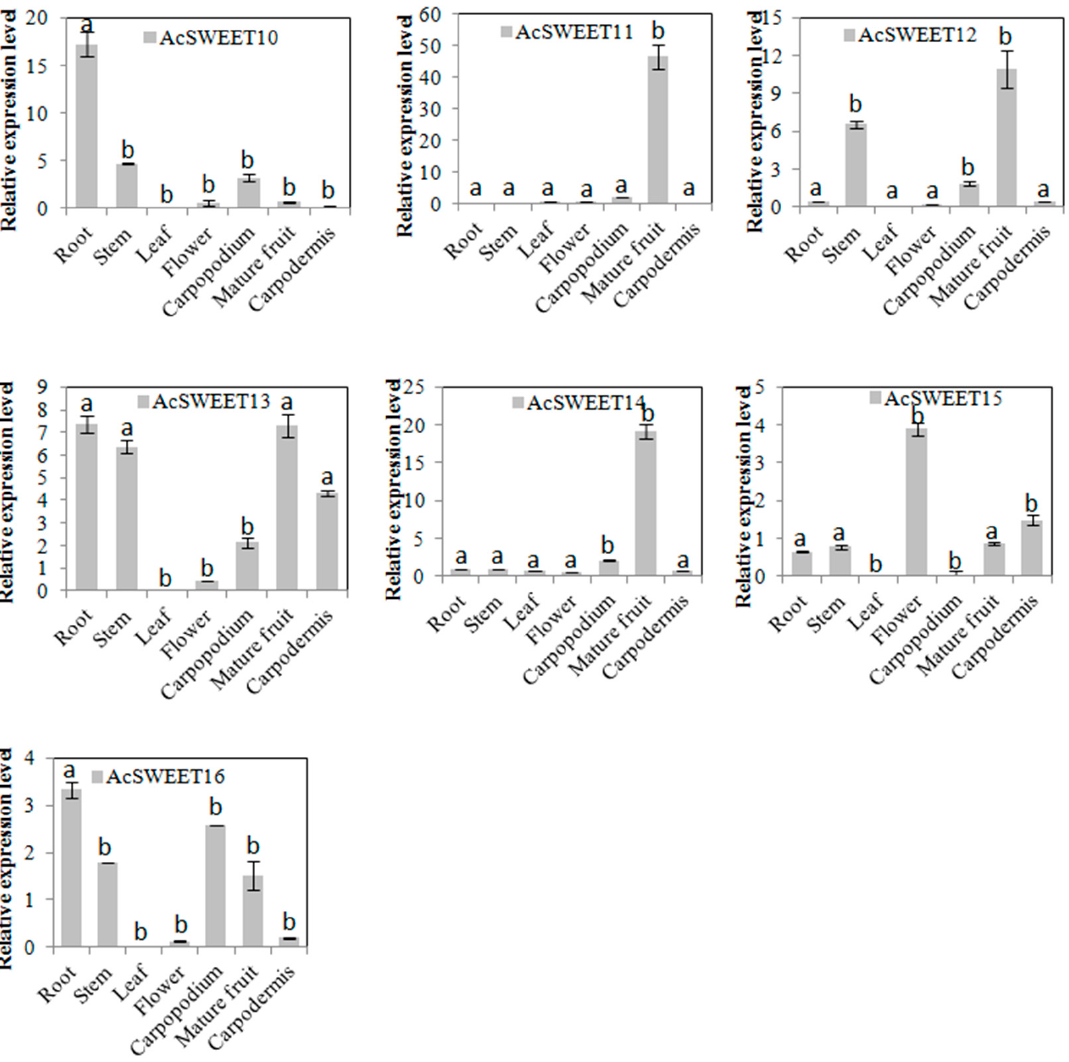
Figure 4. Tissue-specific expression profiles of AcSWEETs in pineapple. Values represented as mean of three biological replicates, and standard deviation bars represented as means ± SD (n = 3). Different letters indicate significant differences at p < 0.05.